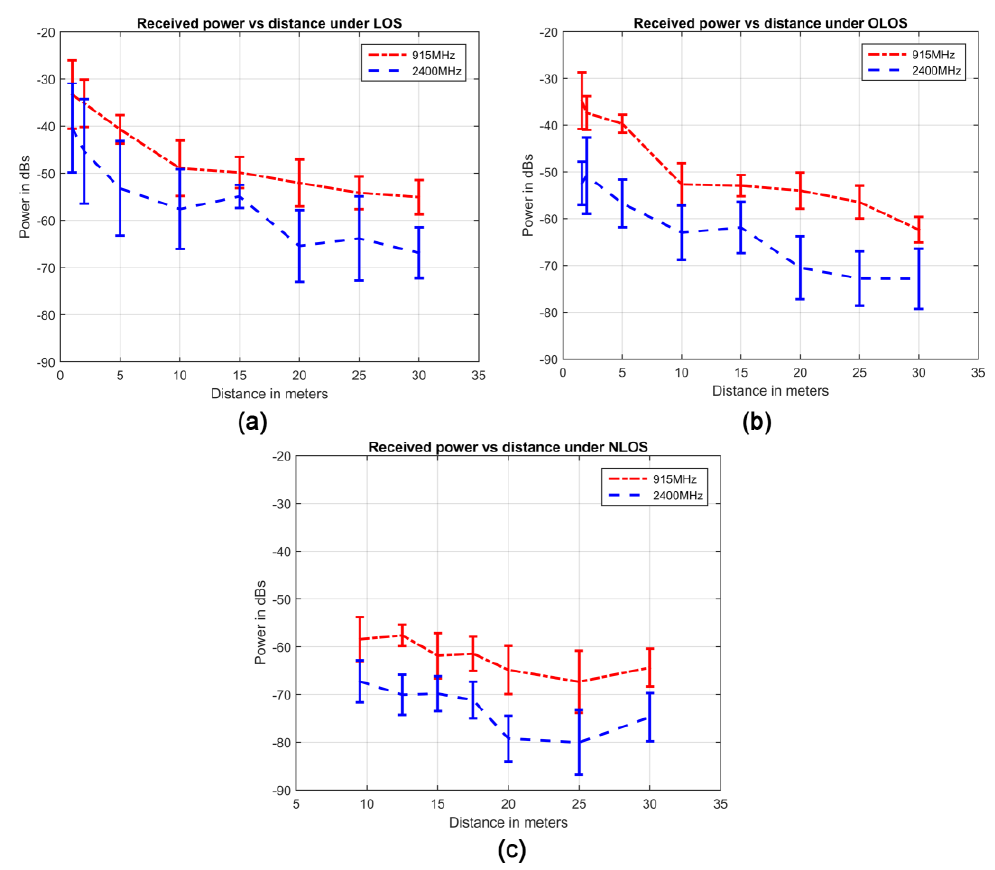
Figure 3. Received power vs. distance for ( a ) LOS, ( b ) OLOS, and ( c ) NLOS visibility conditions in an SG environment. 95% confidence intervals are also included.